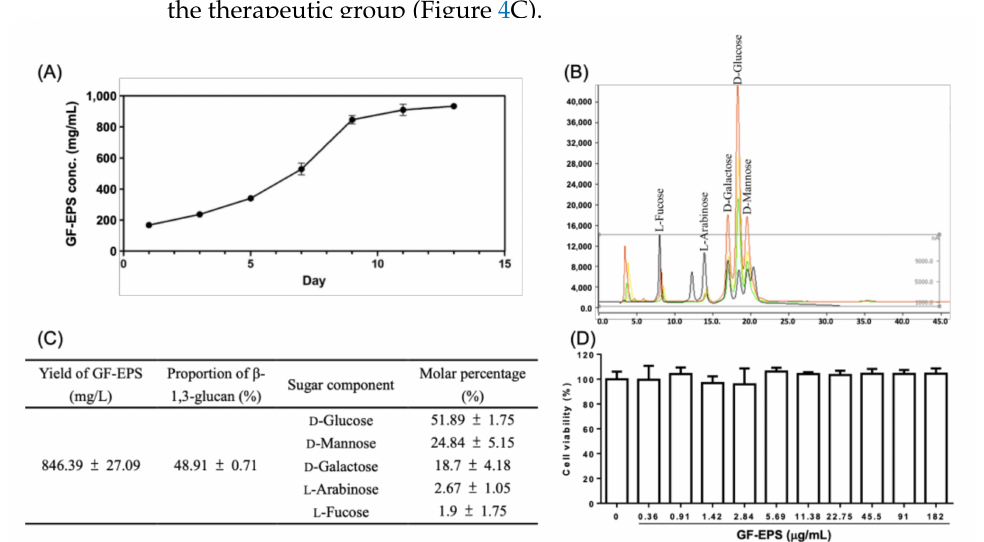
Figure 1. Chemical identification of GF-EPS and cytotoxicity assay. ( A ) Concentration of GF-EPS during fermentation period. ( B ) High performance anion-exchange chromatography with pulsed amperometric detection analysis of the carbohydrate composition of GF-EPS. ( C ) GF-EPS production, β -glucan content, and sugar composition. ( D ) LLC1 cells were treated with GF-EPS for 48 h. Three independent experiments were carried out. Cell viability was calculated as a percentage of the controls. Data are expressed as the mean ± SD.